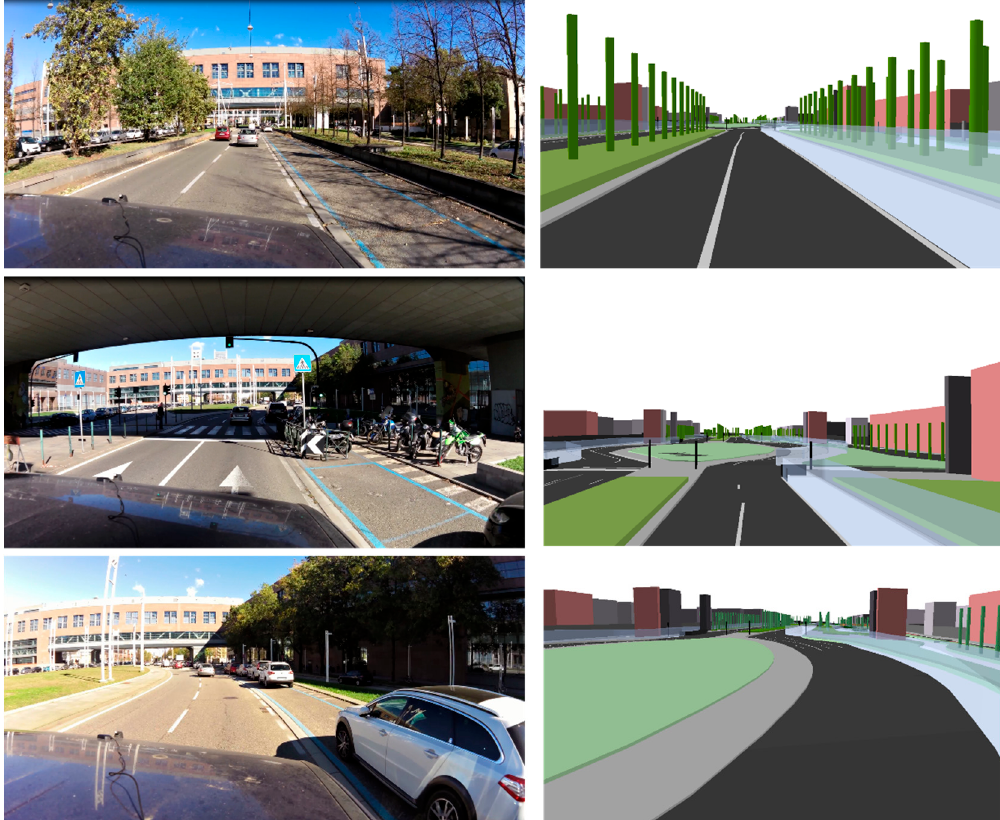
Figure 6. The image captured from the MMS vehicle (on the left) and the updated 3D model reconstructed on the ArcGIS platform (on the right), comprising all the elements existing in the urban infrastructure.